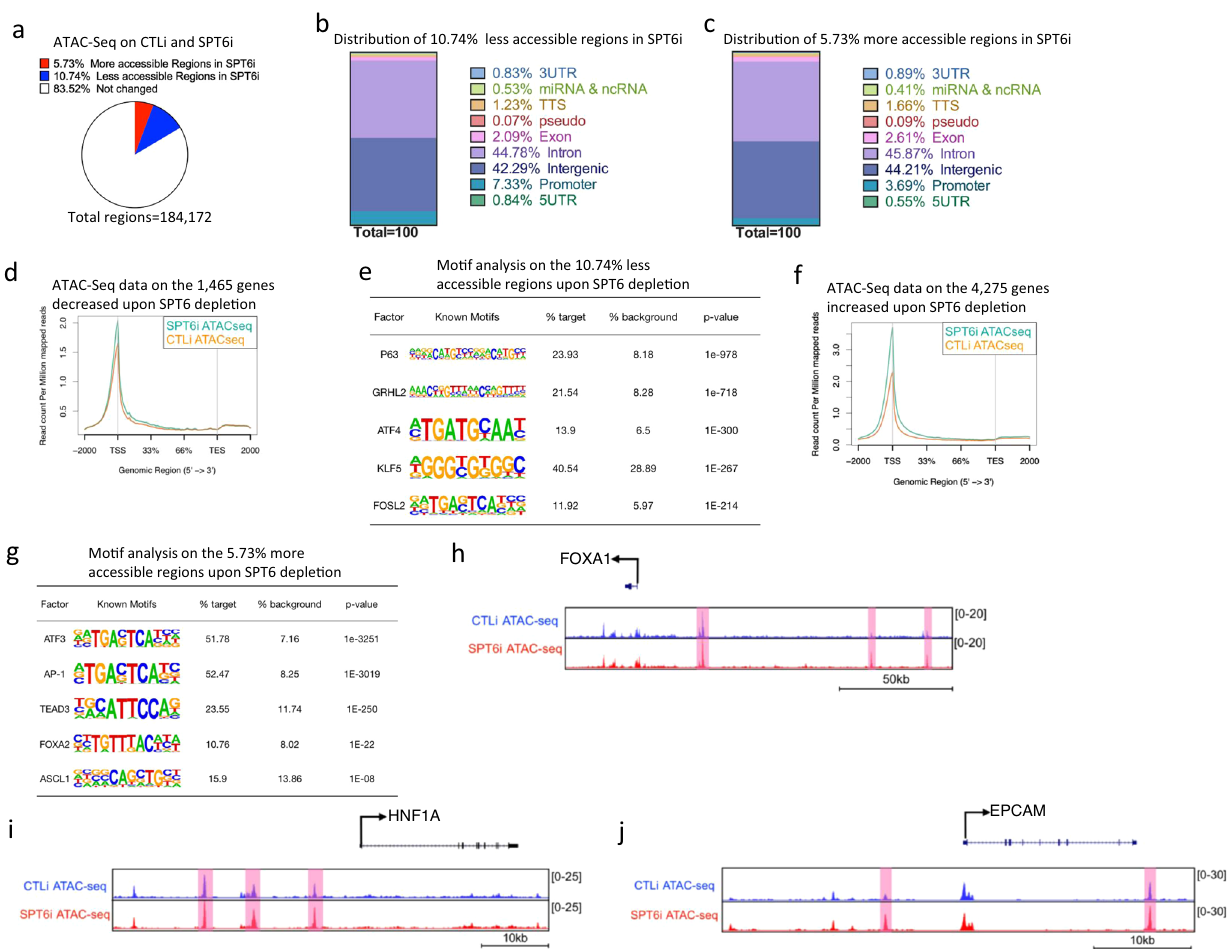
Fig. 5 Depletion of SPT6 leads to loss of chromatin accessibility for P63 binding sites and gain of accessibility for transcription factors specifying other lineages. a Pie chart of the percentage of regions with more or less accessible chromatin upon SPT6 depletion. CTLi and SPT6i samples were differentiated for 3 days and subjected to ATAC-Seq. N = 2 independent experiments. b Distribution of regions with less accessible chromatin upon SPT6 knockdown. c Distribution of regions with more accessible chromatin upon SPT6 loss. d ATAC-Seq signal for the 1465 genes reduced in expression upon SPT6 knockdown. ATAC-Seq signal for CTLi is shown in orange while SPT6i is shown in teal. Read count per million mapped reads is shown on the Y -axis. The X -axis represents regions across genes. TSS is transcription start site and TES is transcription end site. e Transcription factor motif search for the 10.74% regions with less accessible chromatin upon SPT6 knockdown. p value calculated using hypergeometric distribution. f ATAC-Seq signal for the 4275 genes increased in expression upon SPT6 knockdown. ATAC-Seq signal for CTLi is shown in orange while SPT6i is shown in teal. g Transcription factor motif search for the 5.73% regions with more accessible chromatin upon SPT6 knockdown. p value calculated using hypergeometric distribution. Gene tracks showing intestinal genes FOXA1 ( h ), HNF1A ( i ), and EPCAM ( j ). ATAC-Seq signals for CTLi (blue) and SPT6i (red) are shown. Regions marked in pink denote increased chromatin accessibility upon SPT6 depletion. Y -axis represents reads per million. X -axis denotes regions along the